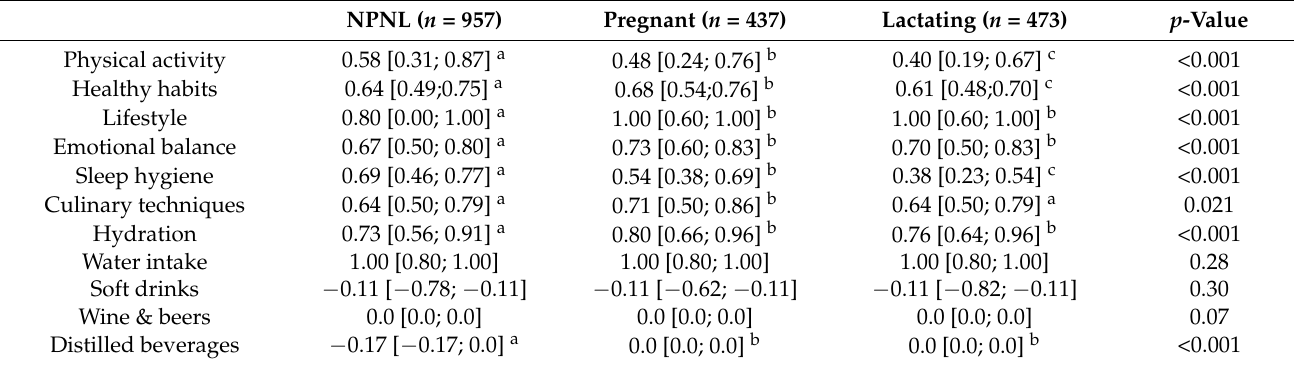
Table 2. Comparison between groups in the physical activity, healthy habits, and hydration